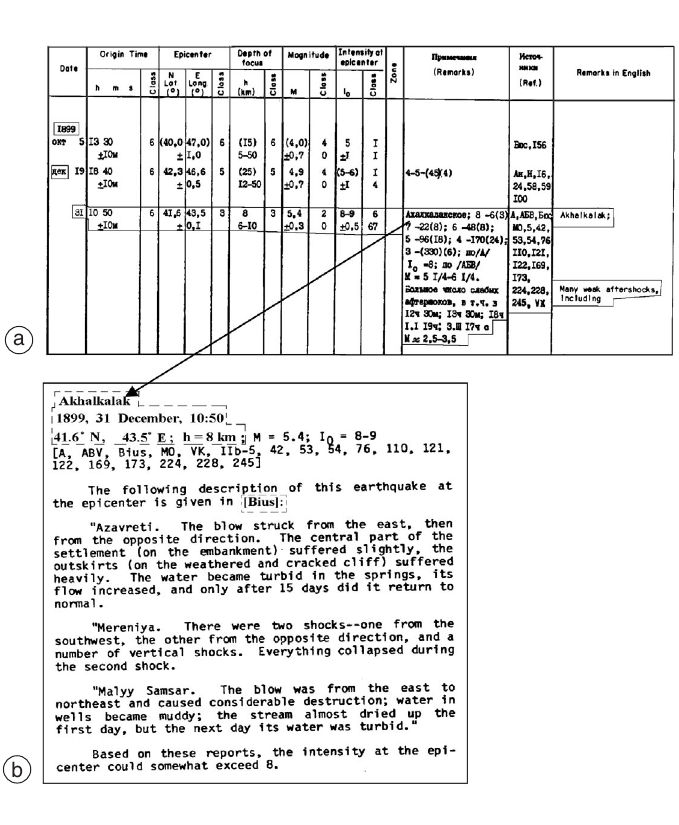
Fig. 4a,b. Information on 31 December 1899, Akhalkalak earthquake in Kondorskaya and Shebalin (1982): a) parametric entry with remarks and b) description of macroseismic effects, referring to Bius (1948) as its